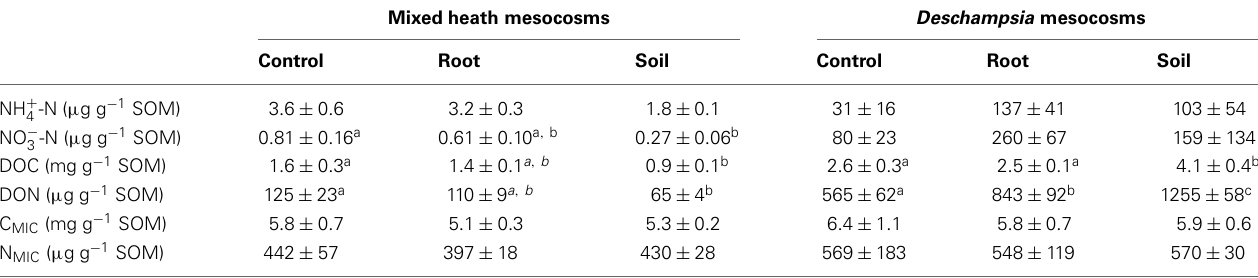
Table 3 | Concentrations of NH + , NO − , dissolved organic carbon (DOC), dissolved organic nitrogen (DON), microbial biomass carbon (C MIC ), 3 4 and microbial biomass nitrogen (N MIC ) in soil from the mixed heath and Deschampsia